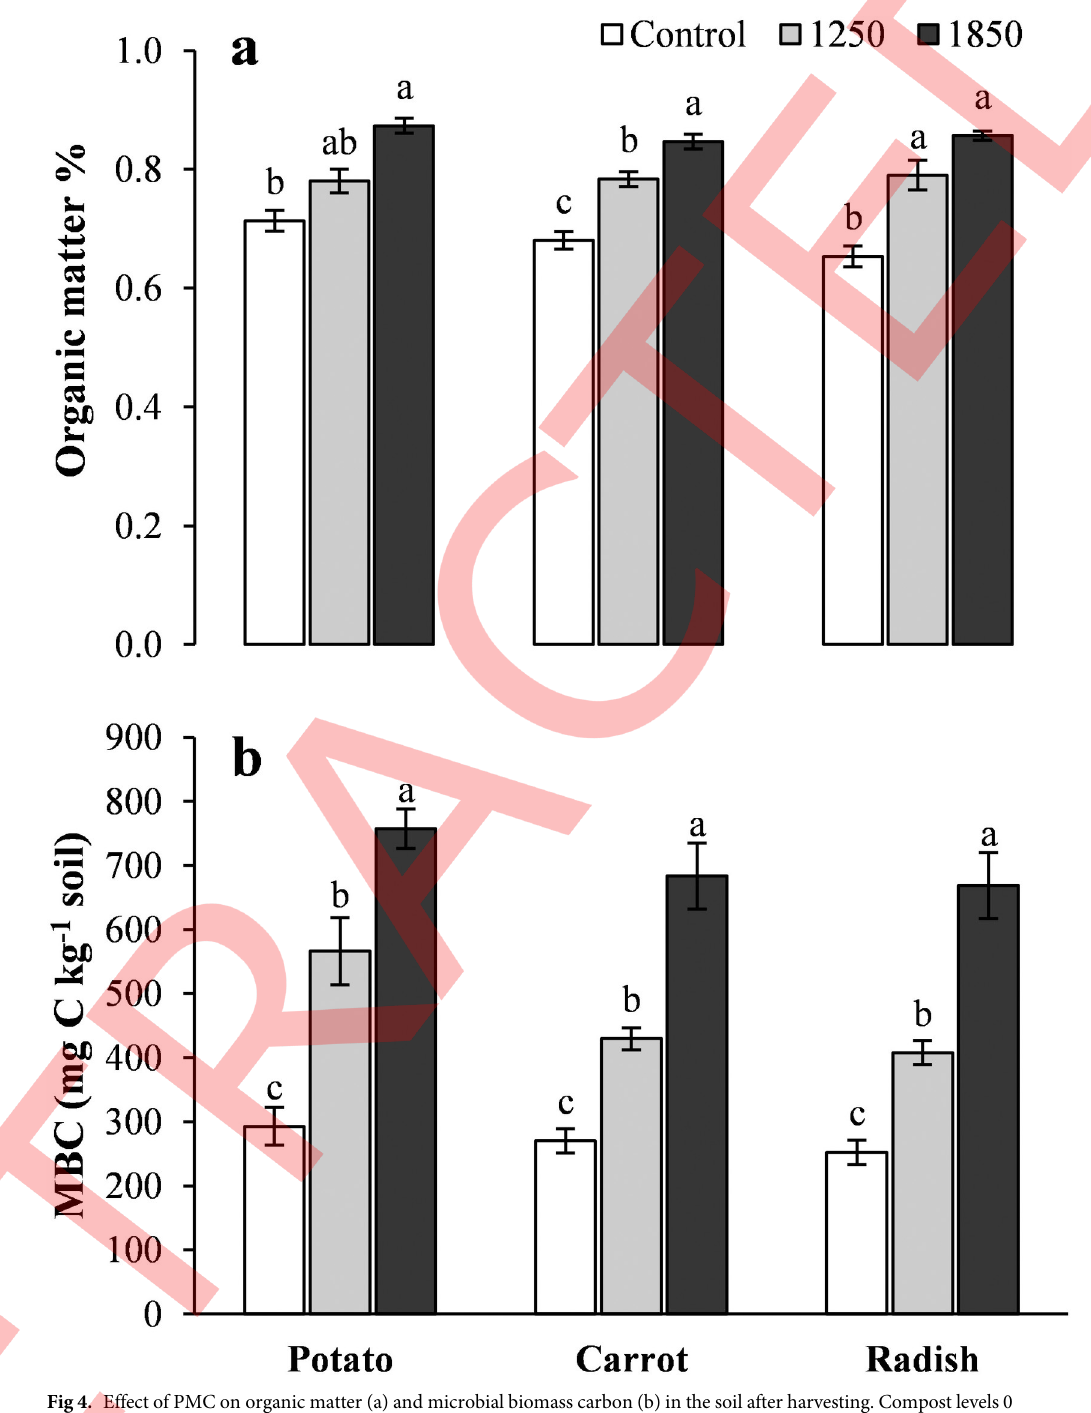
Fig 4. Effect of PMC on organic matter (a) and microbial biomass carbon (b) in the soil after harvesting. Compost levels 0 (Control), 1250 kg compost ha -1 (PMC1) and 1850 kg compost ha -1 (PMC2). The column shows the means of three replications while bars show standard error. Means sharing similar letter (s) do not differ significantly at P � 0.05 according to the LSD